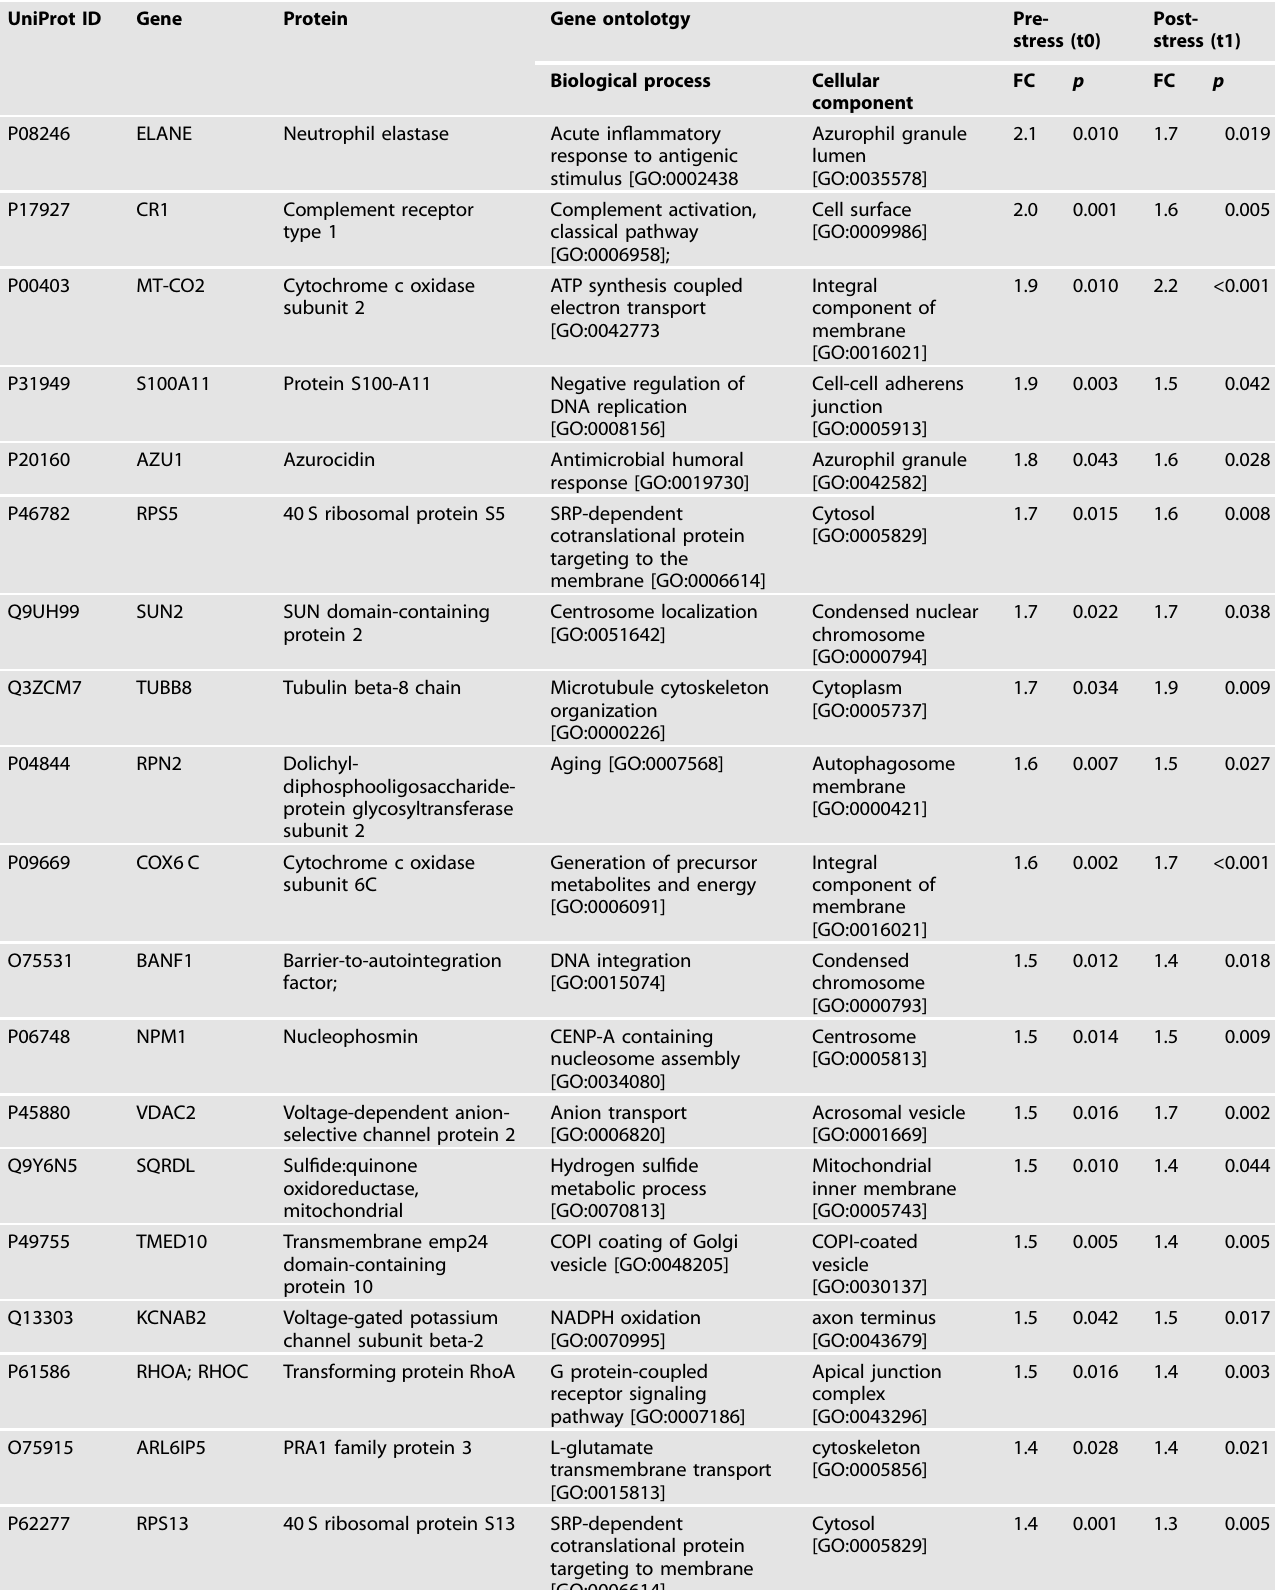
Table 1. Proteins differentially expressed (up - and downregulated) in participants with a history of early adversity before and after stress exposure. UniProt ID